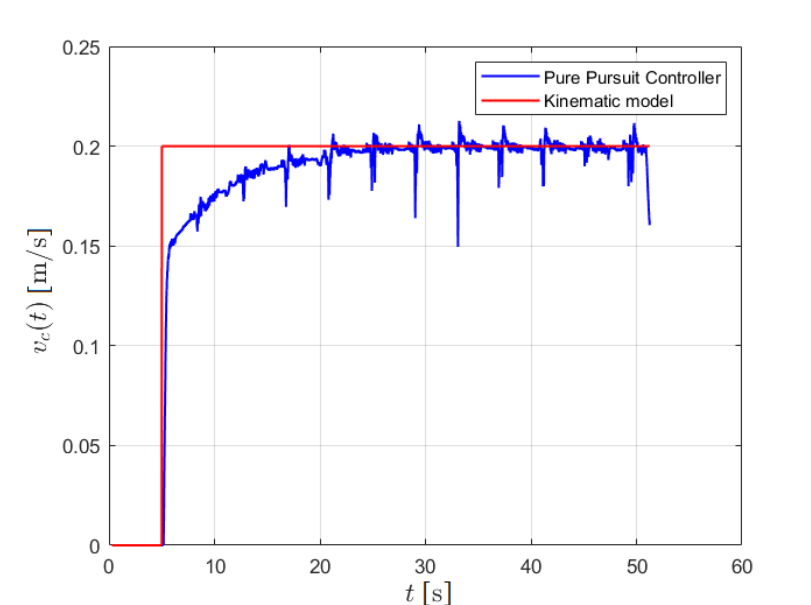
Figure 25. Linear velocity v c ( t ) of the robot.